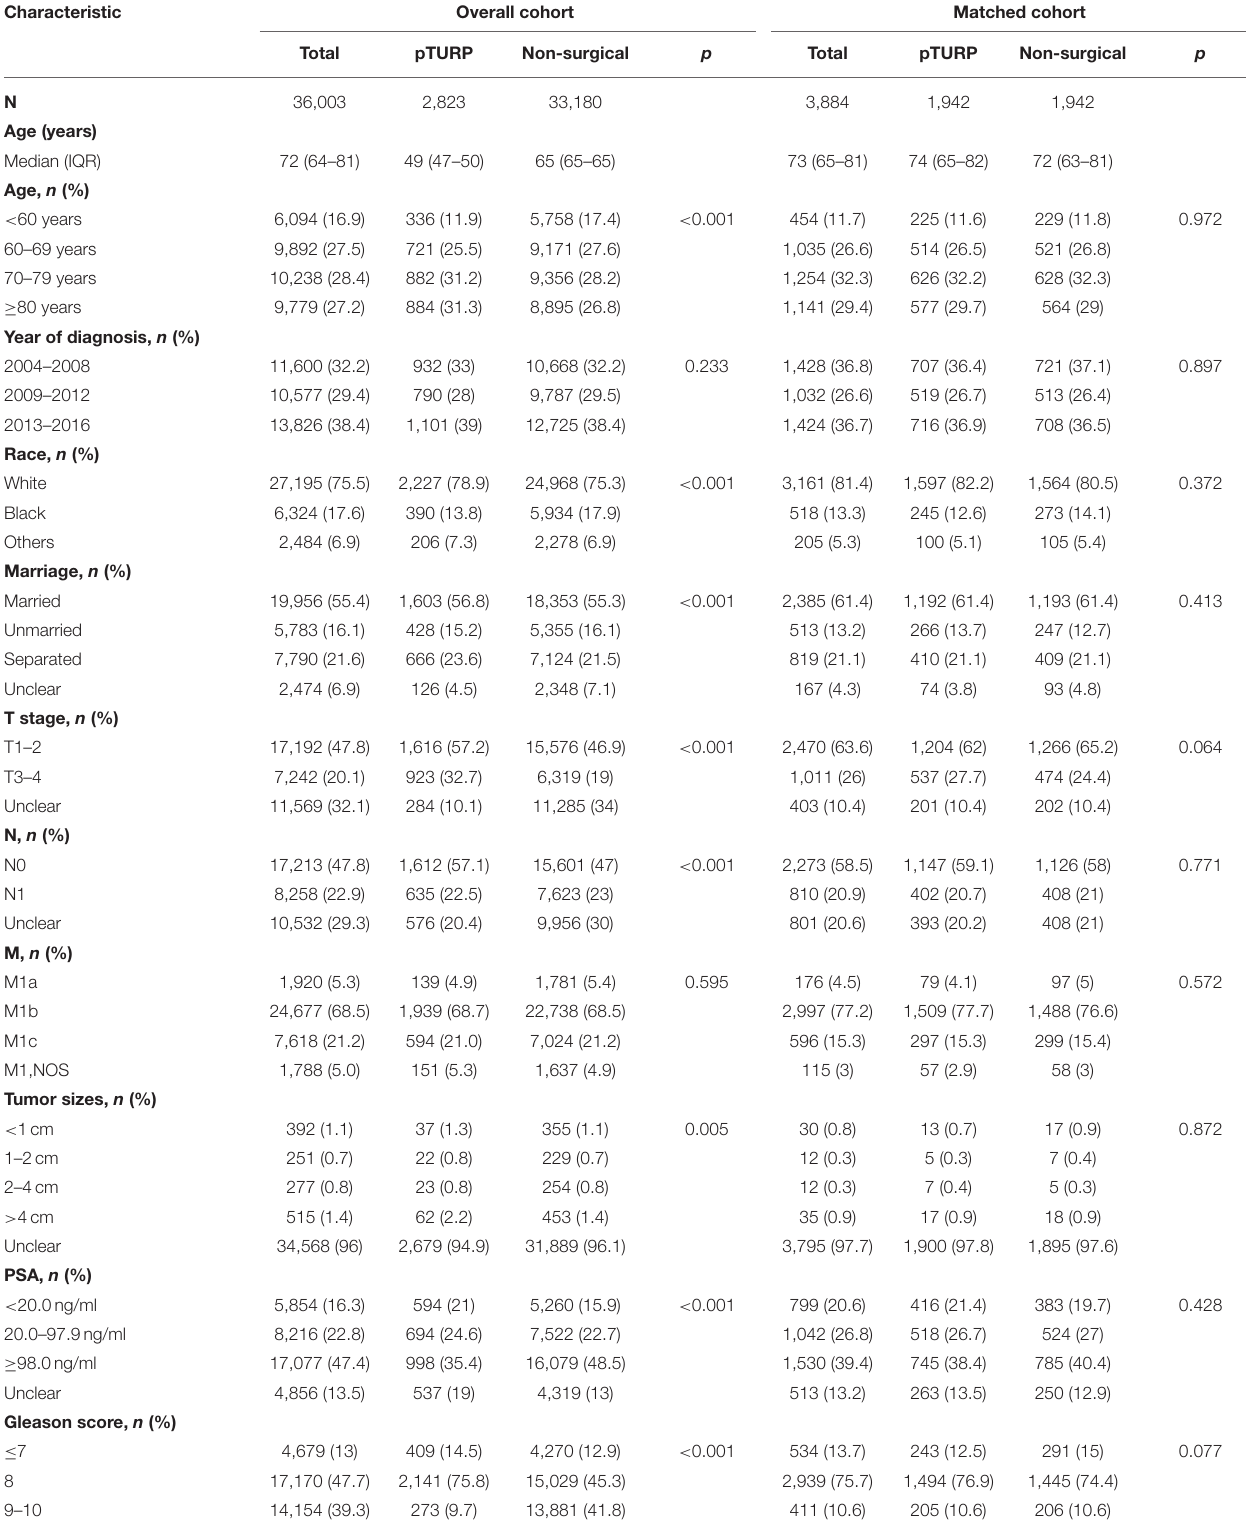
TABLE 1 | Baseline characteristics of included